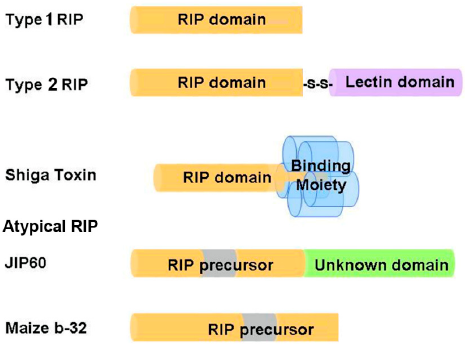
Figure 1. Schematic representation of the organization structures of ribosome-inactivating proteins (RIPs). The RIP domains are colored yellow; lectin domain is colored purple; binding moiety of Shiga toxin is colored blue; unknown domain is colored green; internal inactivation fragments being removed during maturation are colored gray. JIP60 = jasmonate-induced protein.